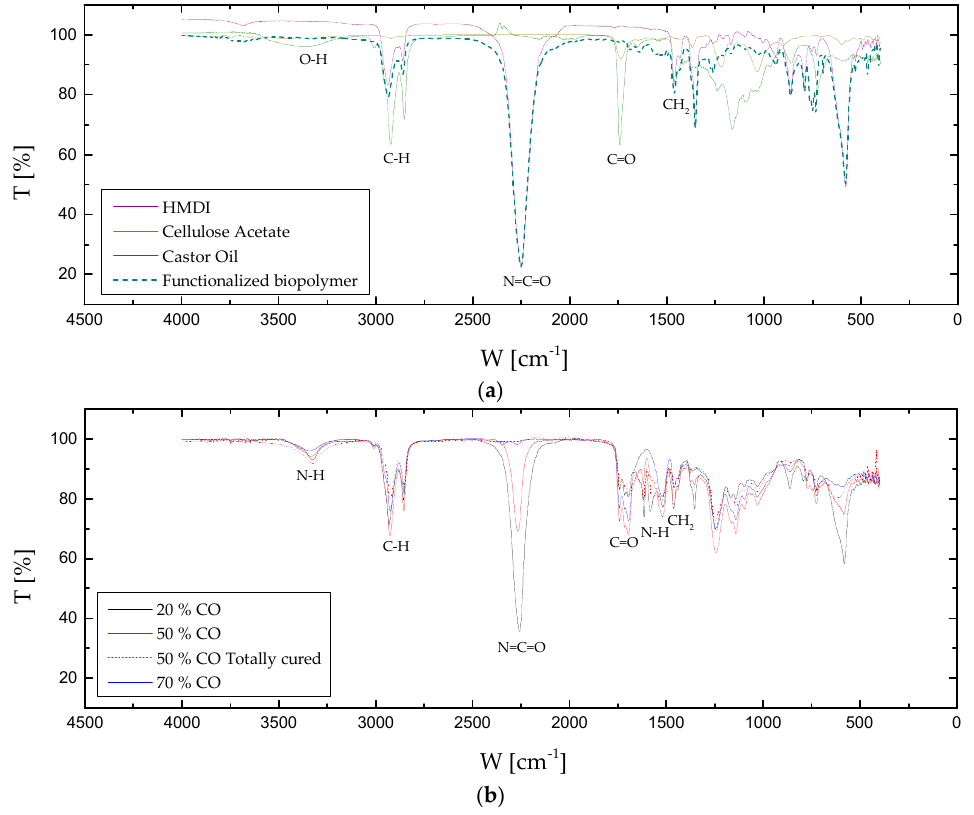
Figure 1. Fourier transform infrared spectroscopic attenuated total reflectance (FTIR-ATR) spectra for: ( a ) 1,6-hexamethylene diisocyanate, cellulose acetate, castor oil and functionalized biopolymer; ( b ) formulation with 20% CO, 50% CO, 70% CO and 50% CO totally cured.